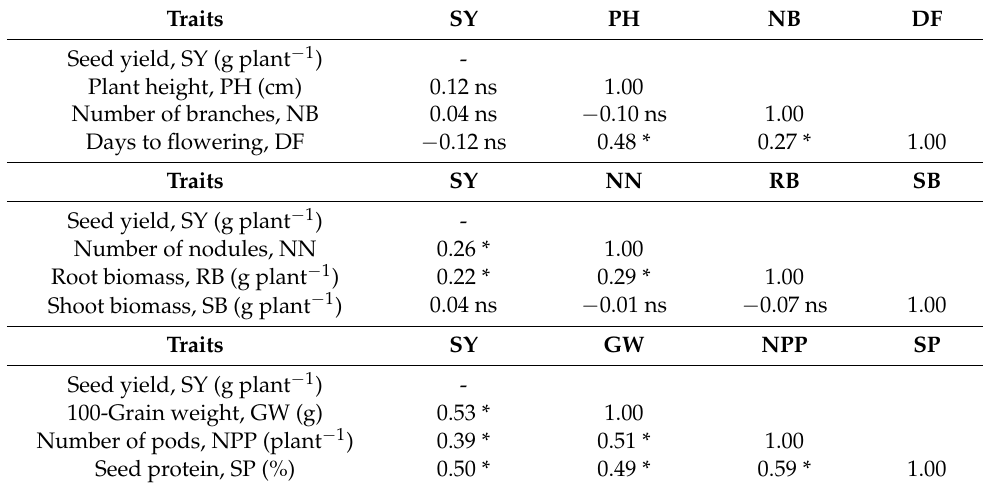
soybean genotypes at different N fertilizer